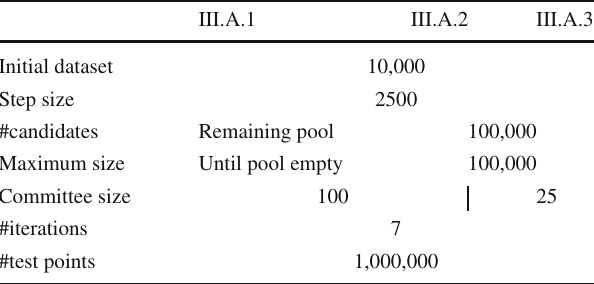
Table 3 Configuration for the active learning procedures in Sect. 3.1